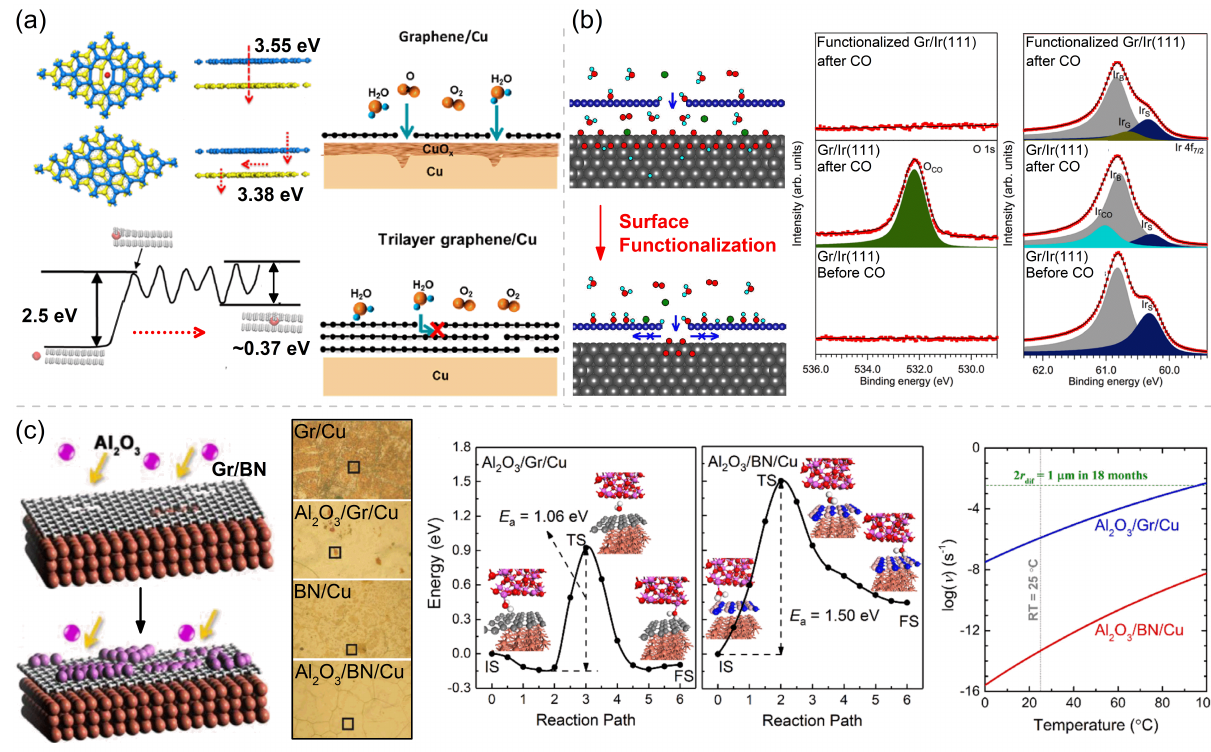
Figure 4. Various micro-control methods to improve the corrosion/oxidation resistance of 2D coatings: ( a ) DFT calculated potential barriers of an O atom permeating into the interlayer of double-layer Gr with matched and mismatched 8-ring defects (adapted with permission from Reference [91], Copyright 2018, Elsevier), schematics and calculated potential barriers for a H 2 O molecule to diffuse through a defective double-layer Gr, and schematics showing the progress of reactive species to diffuse through single-layer Gr (SLG) and few-layer Gr (FLG)-coated Cu (adapted with permission from Reference [40], Copyright 2021, American Chemical Society). ( b ) Schematics of the progresses of reactive species to diffuse through weakly bound Gr–metal and strongly bound Gr–metal interfaces, and the XPS core-level spectra of clean Gr/Ir(111), CO intercalated Gr/Ir(111), and hydrogenated Gr/Ir(111) after exposure to 1 mbar CO at 473 K for 10 min. Adapted with permission from Reference [63]. Copyright 2018, American Chemical Society. ( c ) Schematics of Gr/Cu and BN/Cu surfaces before and after ALD-Al 2 O 3 treatment, optical micrographs of Gr/Cu, Al 2 O 3 /Gr/Cu, h-BN/Cu, and Al 2 O 3 /h-BN/Cu (treated with 80 cycles of ALD) exposed to a humid air for 18 months, and reaction paths and energetic profiles for the diffusion of a H 2 O molecule in Al 2 O 3 /Gr and Al 2 O 3 /BN interfaces and the temperature-dependent diffusion rate for these diffusion processes. Adapted with permission from Reference [90]. Copyright 2020,